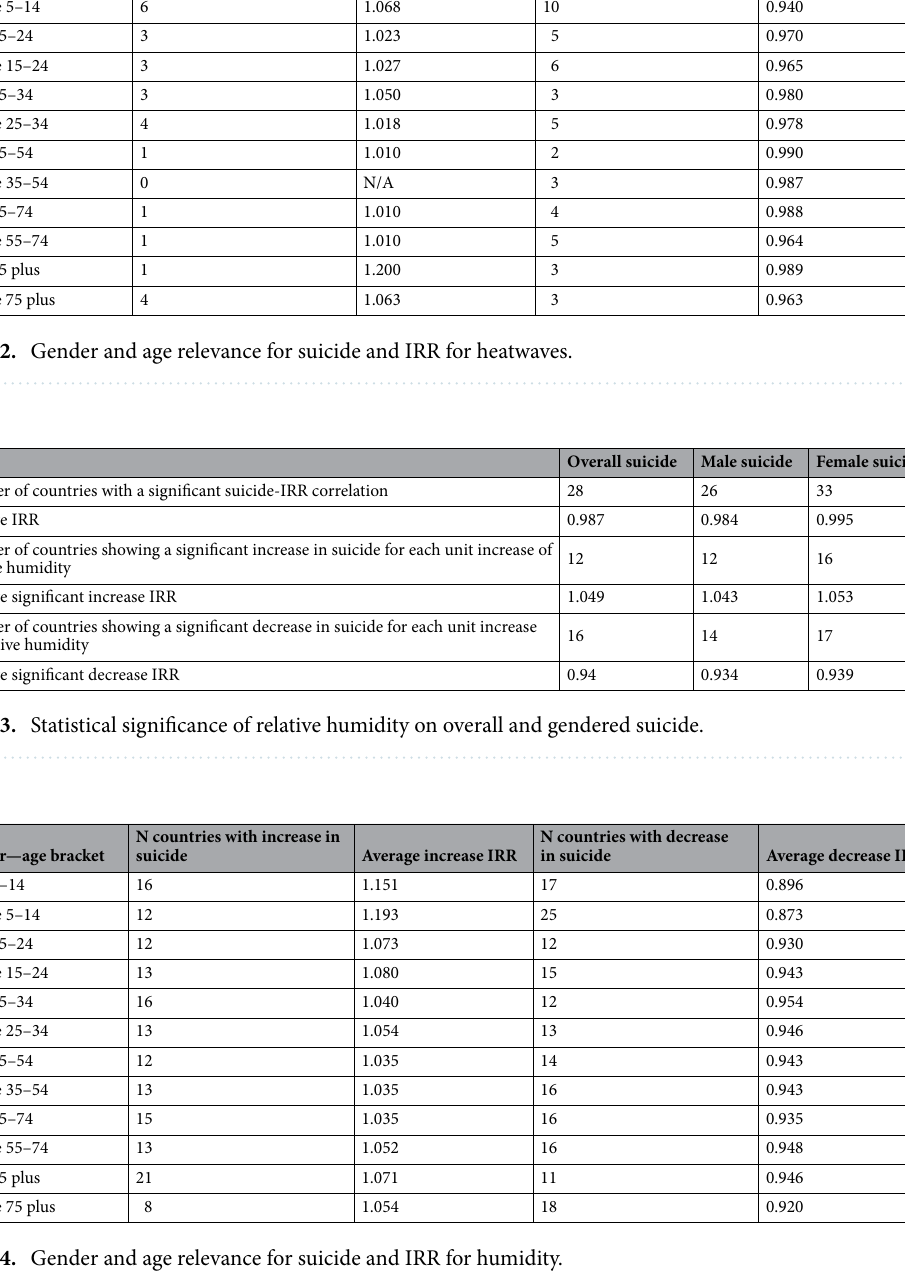
Table 4. Gender and age relevance for suicide and IRR for humidity.